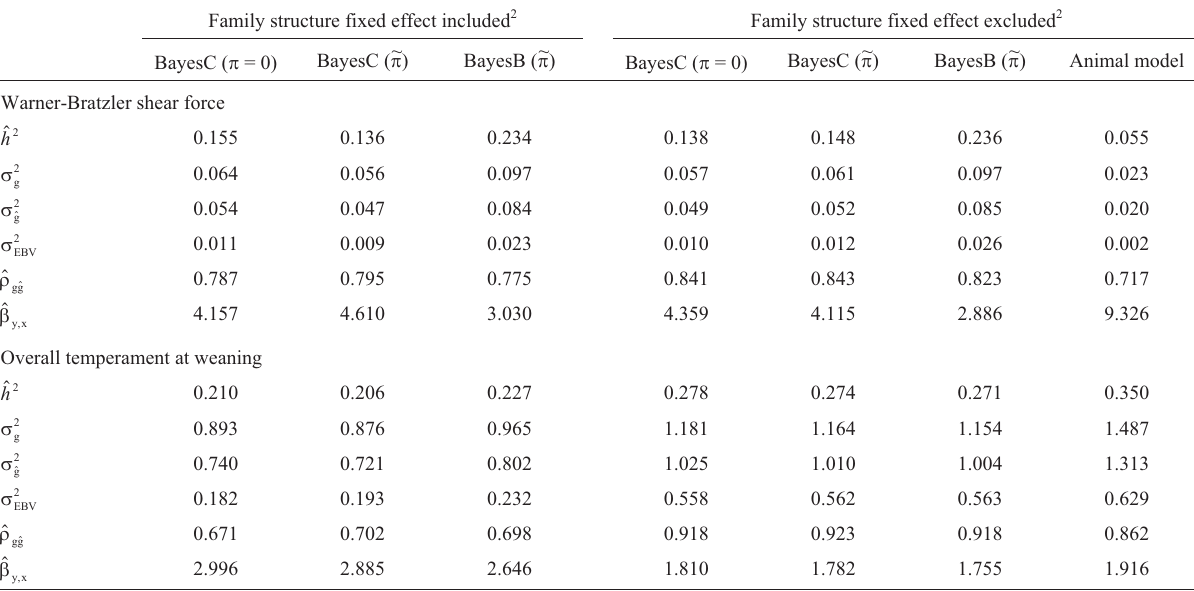
Table1 -Geneticparameterestimates( (cid:2) h 2 , (cid:6) g2 , (cid:6) force and overall temperament at weaning for 4 models 1